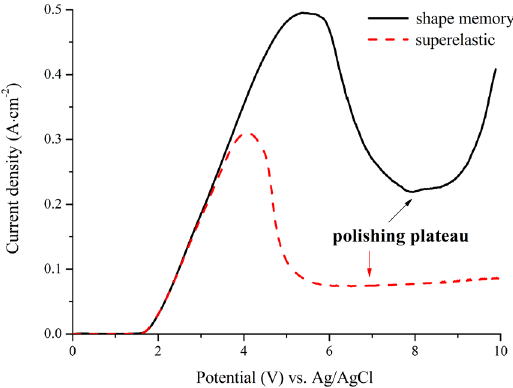
Figure 2. Anodic polarization curves of NiTi wires in 3.5 mol•L -1 methanolic H SO 2 4